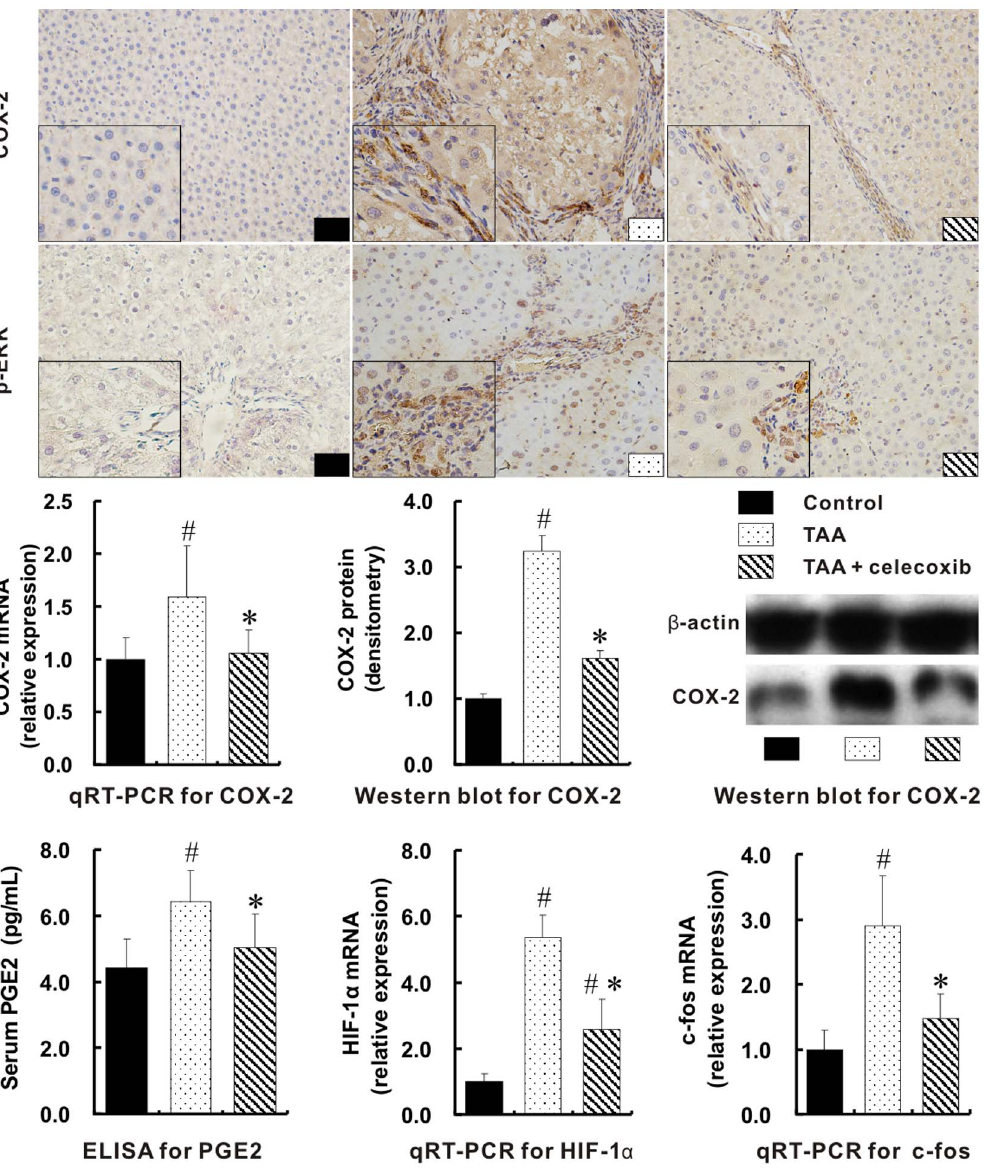
Figure 4. Suppression of the integrated signal pathways with celecoxib treatment. Much more positive expressions for COX-2 and p-ERK were visualized in TAA group (Immunohistochemical stain, 6 400 magnifications; inserts, 6 1000 magnifications). The mRNA and protein levels of hepatic COX-2 in TAA group measured with qRT-PCR and Western blot separately were the highest among three groups. The serum levels of PGE2 were measured by ELISA. The mRNAs for HIF-1 a and c-fos were determined by qRT-PCR. # p , 0.01 vs . control group; * p , 0.01 vs . TAA